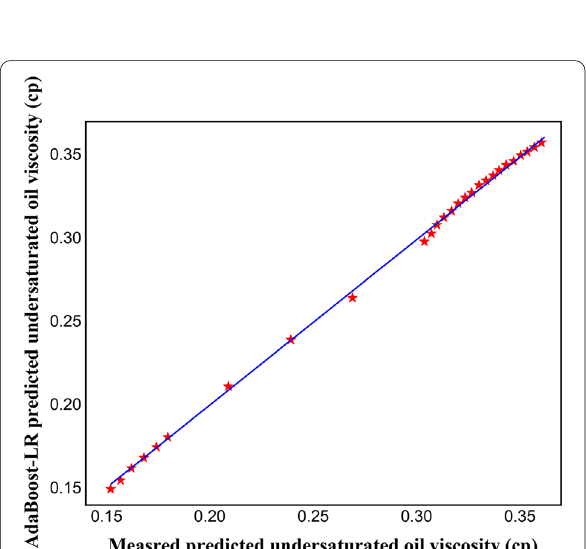
Fig. 19 Cross plot of AdaBoost-LR predicted values versus measured values